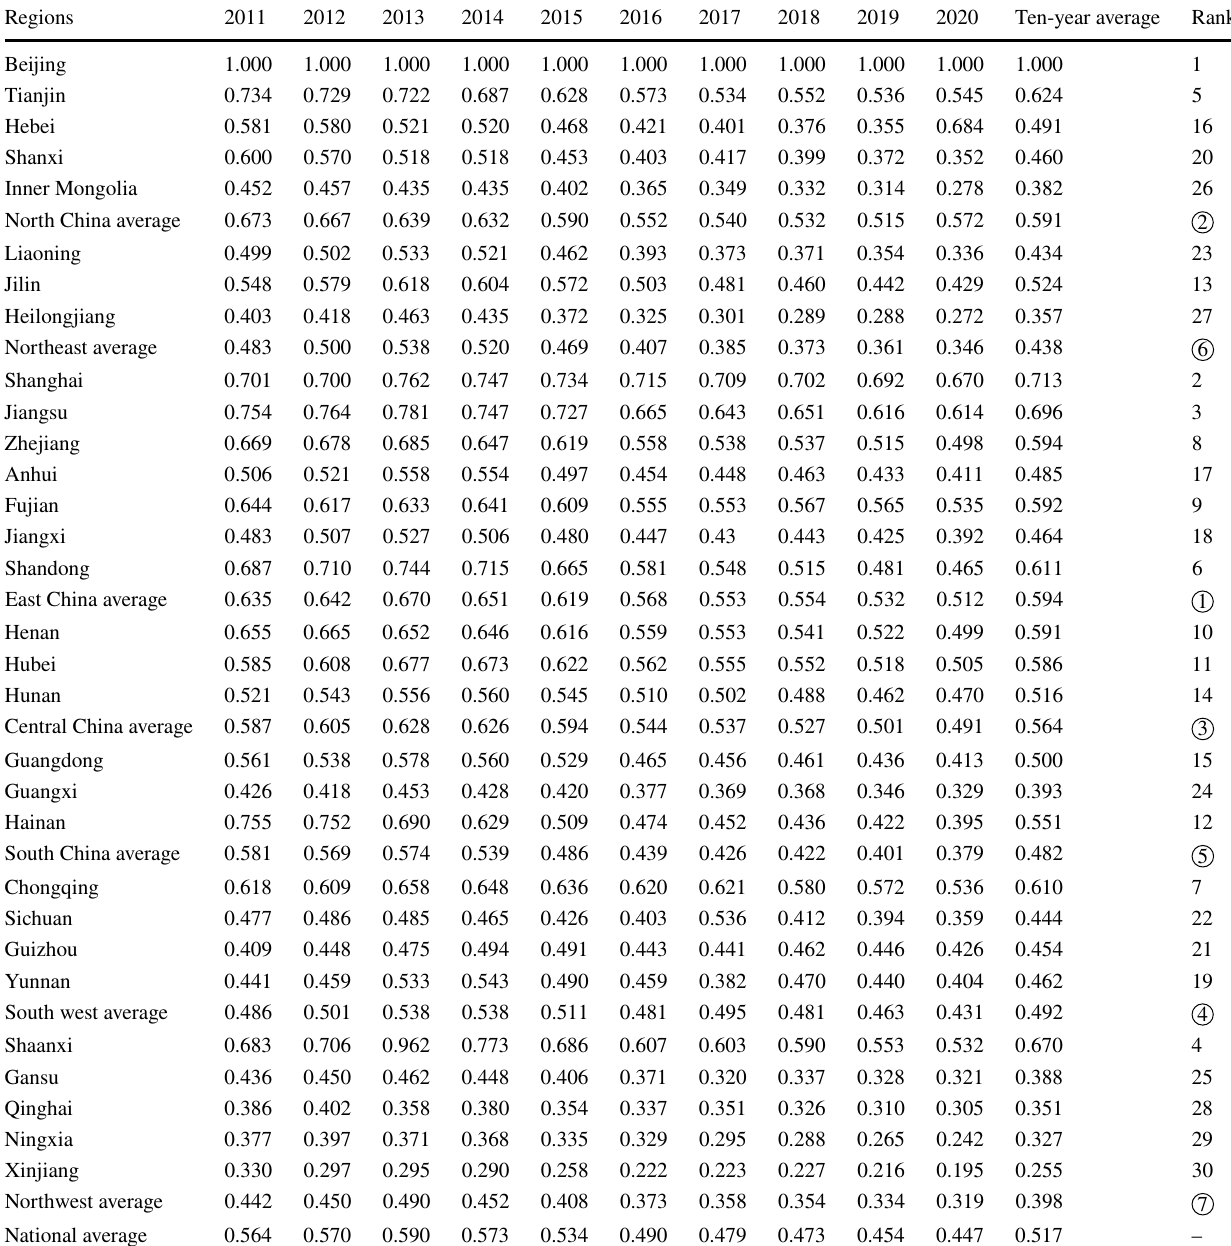
Table 11 Satisfaction cross-efficiency for the W–E–F nexus input–output by region from 2011 to 2020